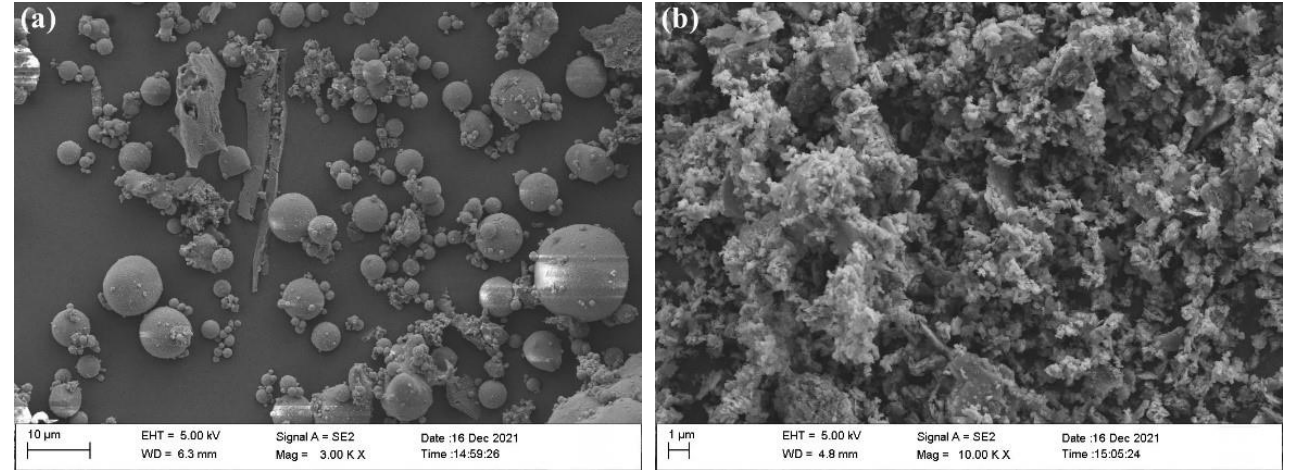
Figure 1. SEM image of ( a ) fly ash and ( b ) metakaolin.